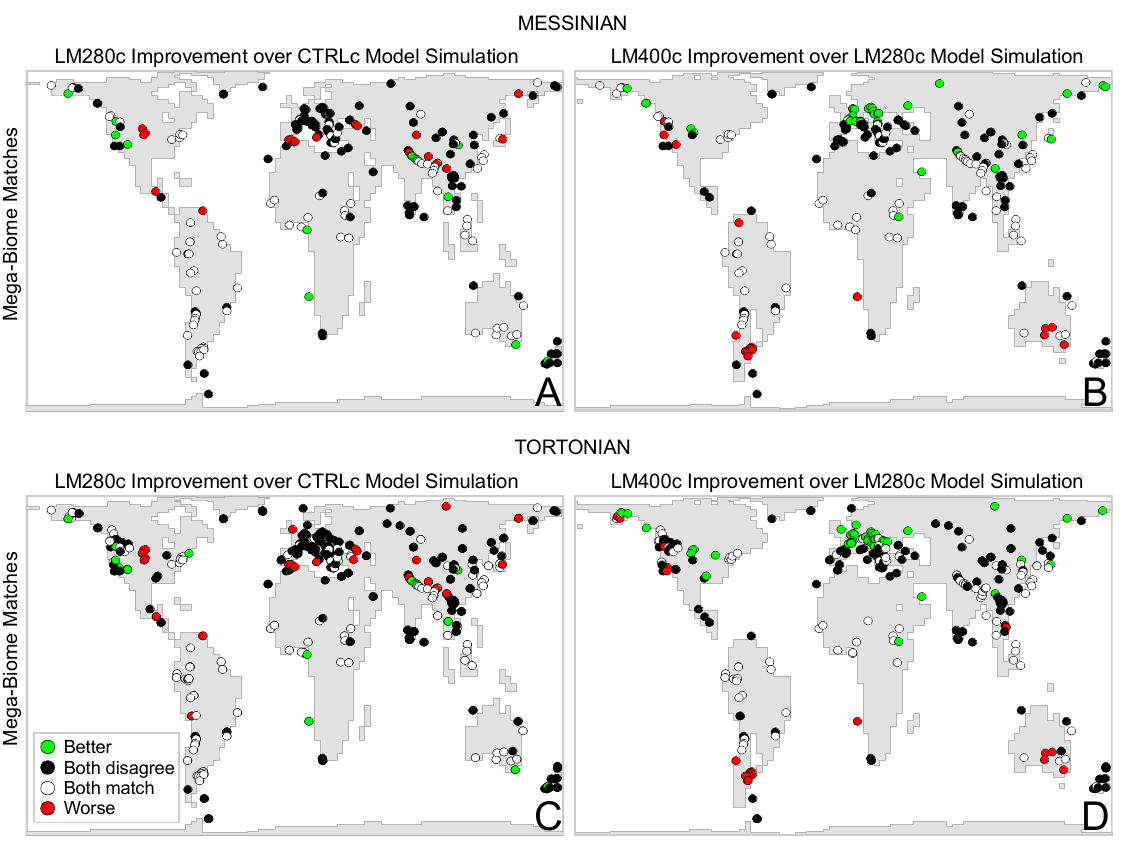
Fig. 16. Improvements in the model–data comparison for megabiomes. Panels (A) and (C) show the improvement that the late Miocene palaeogeography makes to the model–data comparison. Panel (B) and (D) show the improvement that higher CO 2 makes to the model–data comparison. Green circles indicate an improvement; red circles indicate a